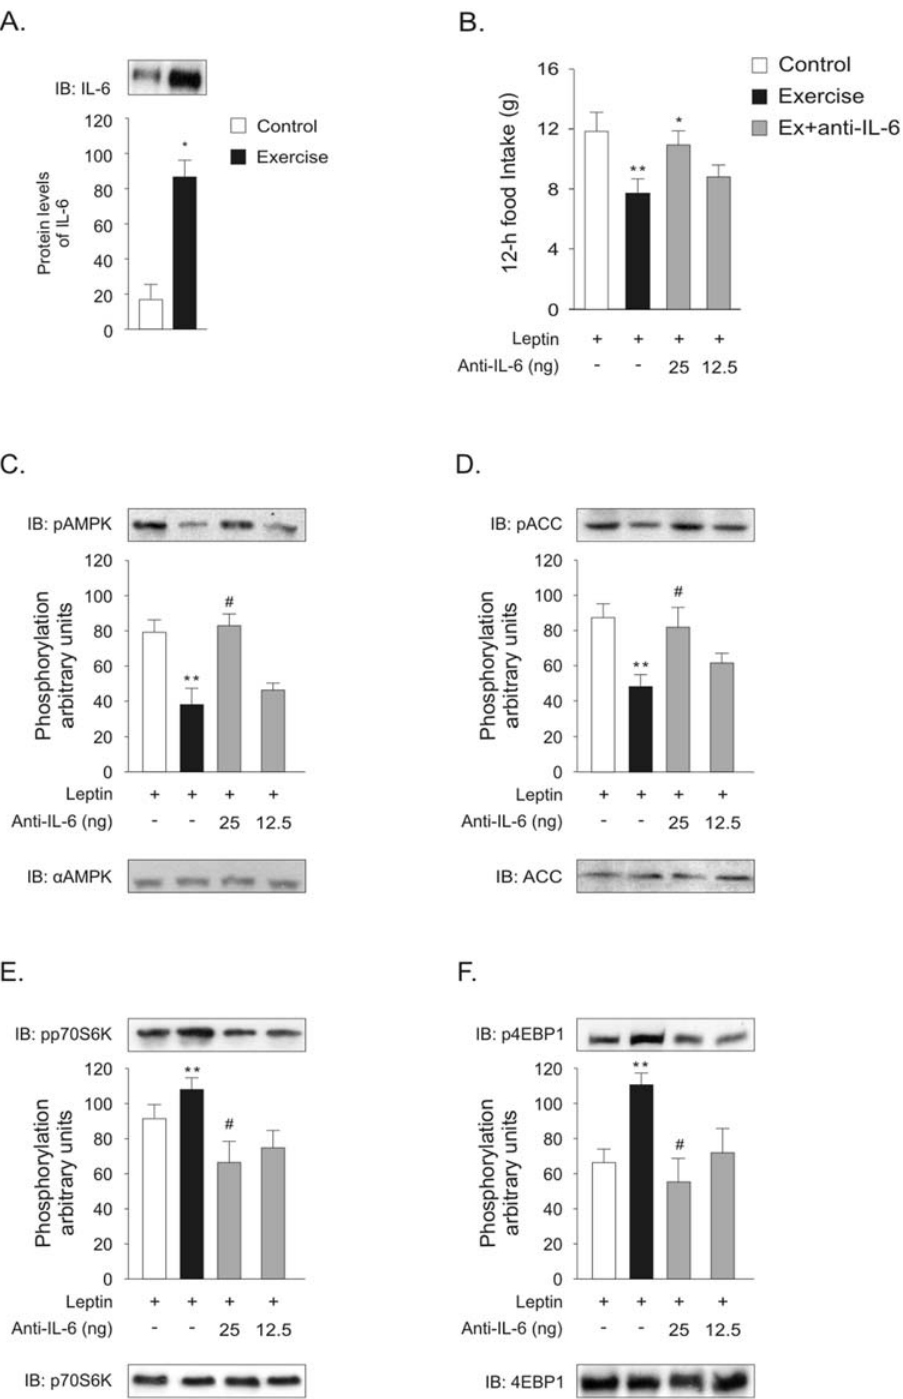
Figure 6. Blockade of leptin induced inhibition of food intake by anti–IL-6 antibody. Hypothalami from rats were prepared as described in Research Design and Methods . (a) Tissue extracts from control and exercised rats were immunoblotted with anti–IL-6 antibody. (b) Leptin was injected intracerebroventricularly in control rats, exercised rats and exercised rats pretreated with anti–IL-6 at the doses indicated, and the animals were immediately exposed to food for a 12-hour period ( n =10–12 animals per group). (c, d, e, f) Representative Western blots of four independent experiments showing hypothalamic lysates from Wistar rats. Phospho-AMPK thr172 , threonine-phosphorylated AMPK and total AMPK (c); phospho- ACC ser79 , serine phosphorylated ACC and total ACC (d); phospho-p70S6Kinase thr389 , threonine phosphorylated p70S6Kinase and total p70S6K (e); phospho-4EBP1 thr70 , threonine phosphorylated 4EBP1 and total 4EBP1 (f). Data are the means 6 SEM. * p , 0.05, vs. control, ** p , 0.05, vs. control plus leptin, # p , 0.05, vs. exercise plus leptin.